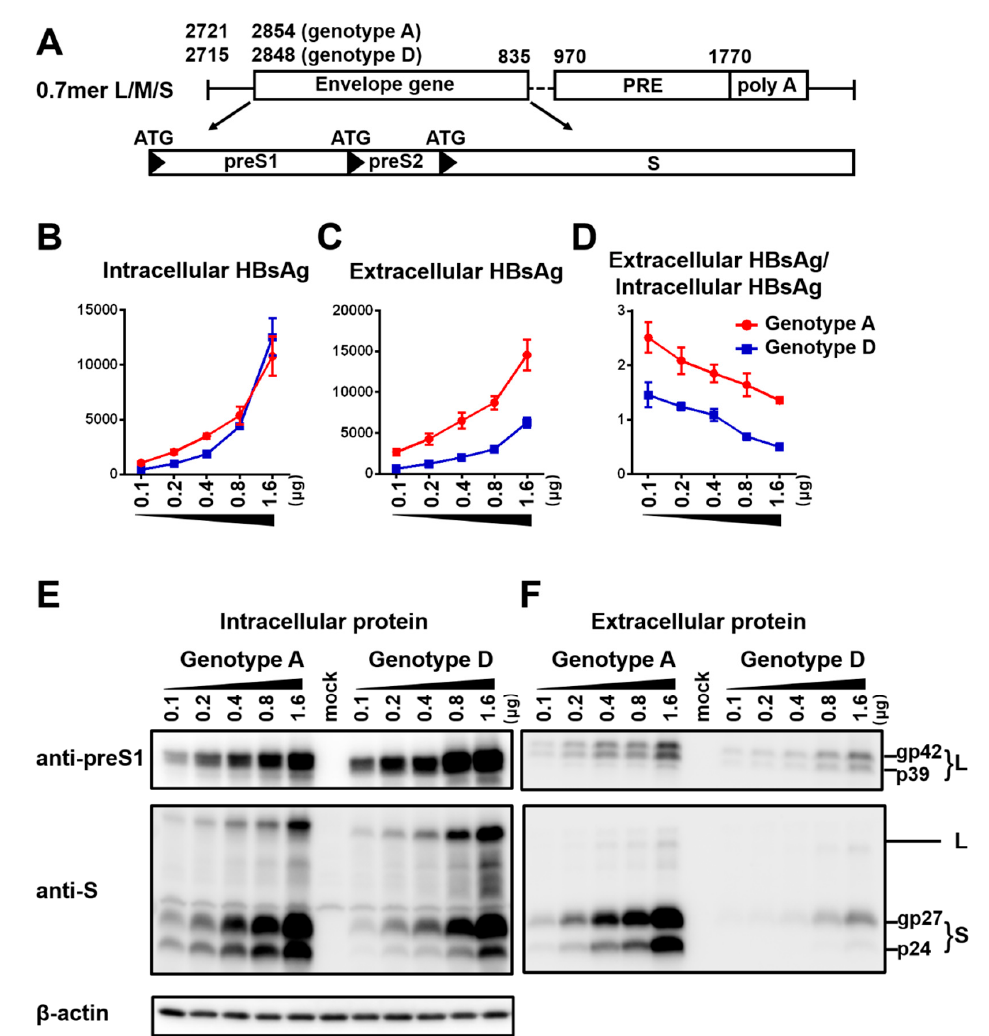
Figure 2. Impact of DNA dosage and viral genotype on envelope protein expression and HBsAg secretion from 0.7 mer L/M/S construct. ( A ) Schematic representation of the 0.7 mer L/M/S construct, with three in-frame ATGs driving L, M, and S protein translation. ( B – F ) Huh7 cells seeded in 6-well plates were transfected with indicated amount of 0.7 mer L/M/S construct of geno5.4 (genotype A) or geno1.2 (genotype D), with the total DNA amount adjusted to 2 μ g/well. Cells and culture supernatant were harvested four days later. ( B , C ) Total amount of HBsAg (OD 450 ) from cell lysate ( B ) and culture supernatant ( C ), with data averaged from three independent transfection experiments. ( D ) Calculated ratio of extracellular/intracellular HBsAg. ( E , F ) Western blot analysis of intracellular ( E ) and extracellular ( F ) L and S proteins from same volume of cell lysate or culture supernatant by anti-preS1 and anti-HBs antibodies, respectively. β -actin served as an intracellular loading control.